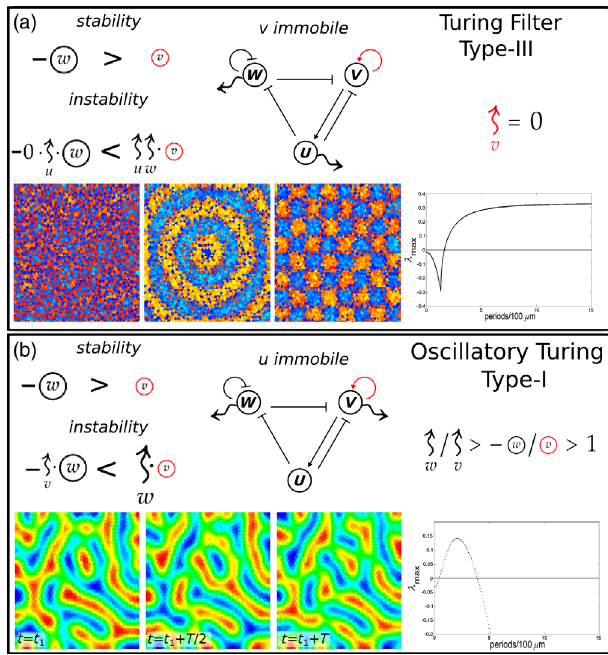
FIG. 4. Permutation of the immobile node in a three-node topology results in (a) a Turing filter because the destabilizing module is formed by a single immobile node. The simulations show the amplification of noisy, circular, and checkerboard initial conditions. The dispersion relationship, saturating at large wave numbers, determines the threshold for pattern amplification. (b) An oscillatory network of type I. The time points of the simulation show a spatially stationary and temporally oscillatory pattern. The real part of the eigenvalue (the dotted line in the dispersion relationship) determines the wavelength and the complex part (not shown) of the time period. In both panels, stability and instability requirements are shown on the left, with diffusion constraints on the